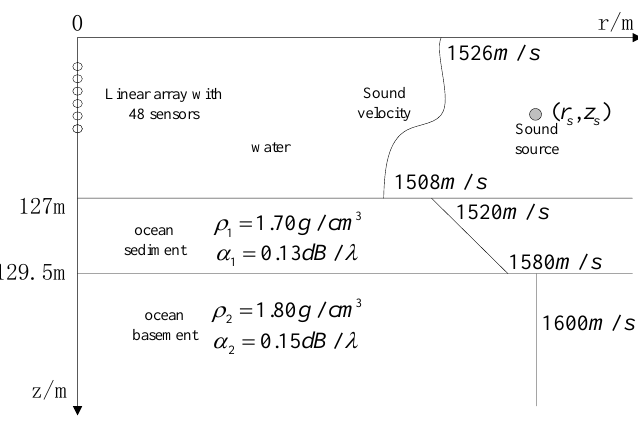
Figure 6. Environmental model in shallow water.